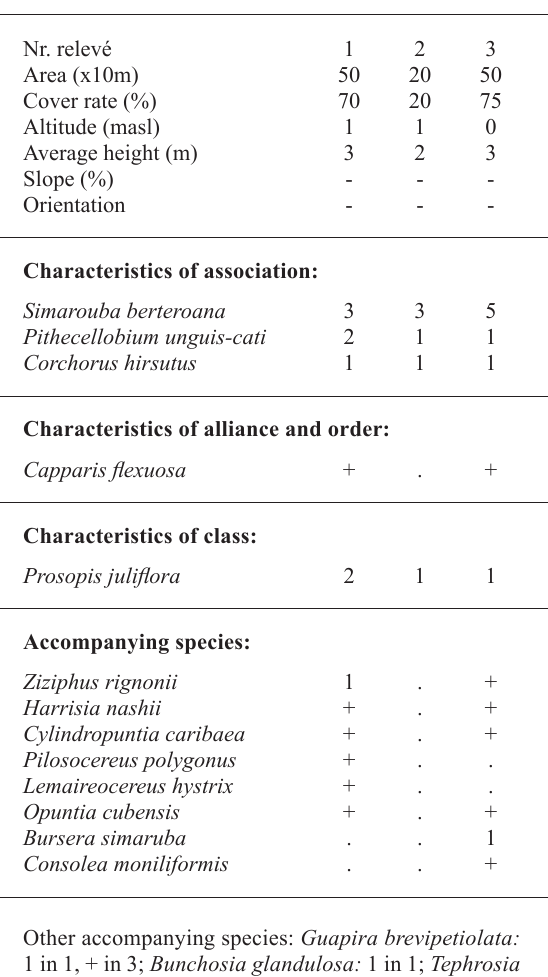
Simaroubetum berteroani ass.